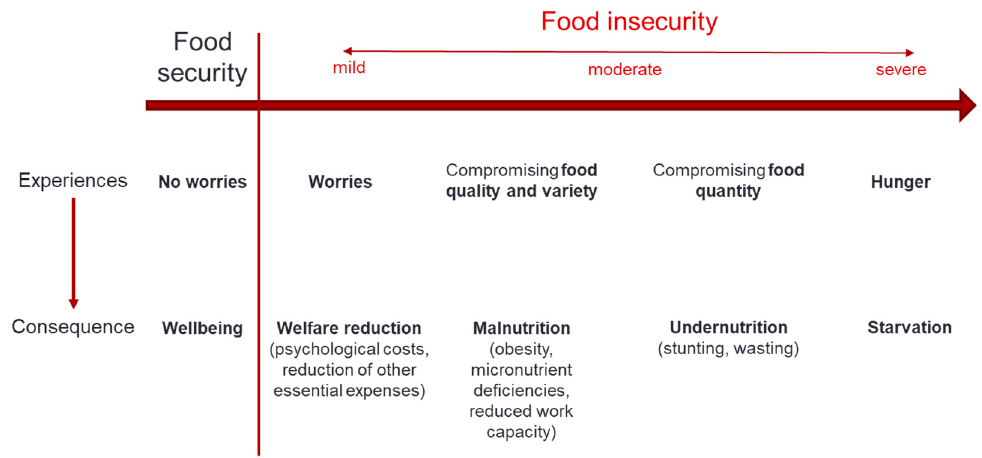
Figure 1. From Food Security to Food Insecurity (adapted from Cafiero/FAO, 2013) [5].